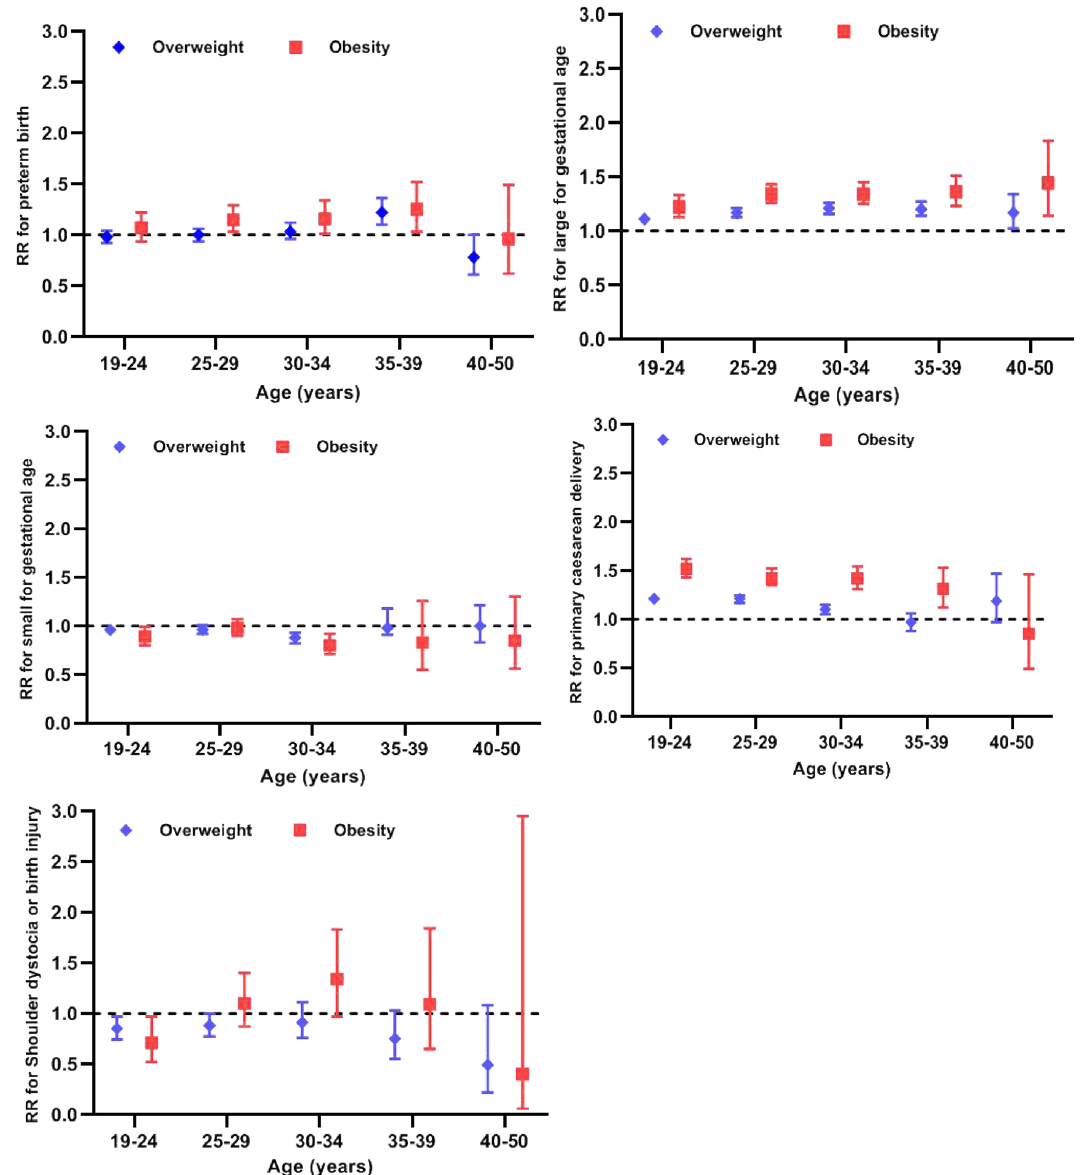
Figure 3. Association of pre-pregnancy overweight and obesity with the risk of 5 adverse pregnancy outcomes by maternal age